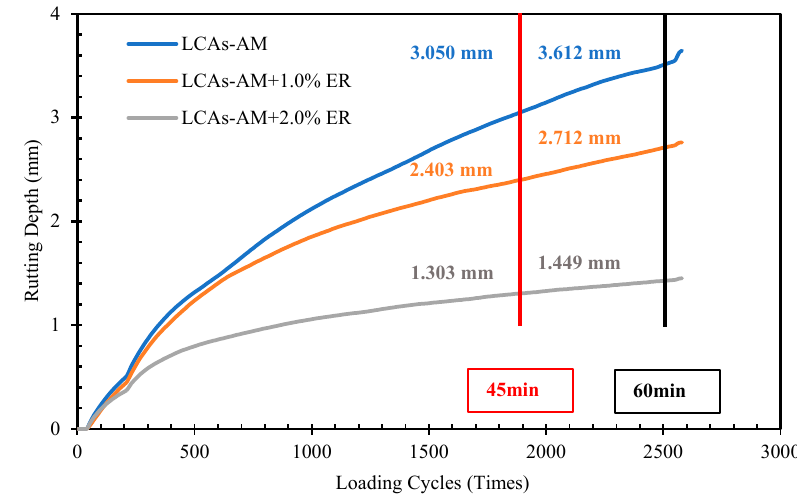
Figure 7. Rutting depth increase curve of asphalt mixtures.